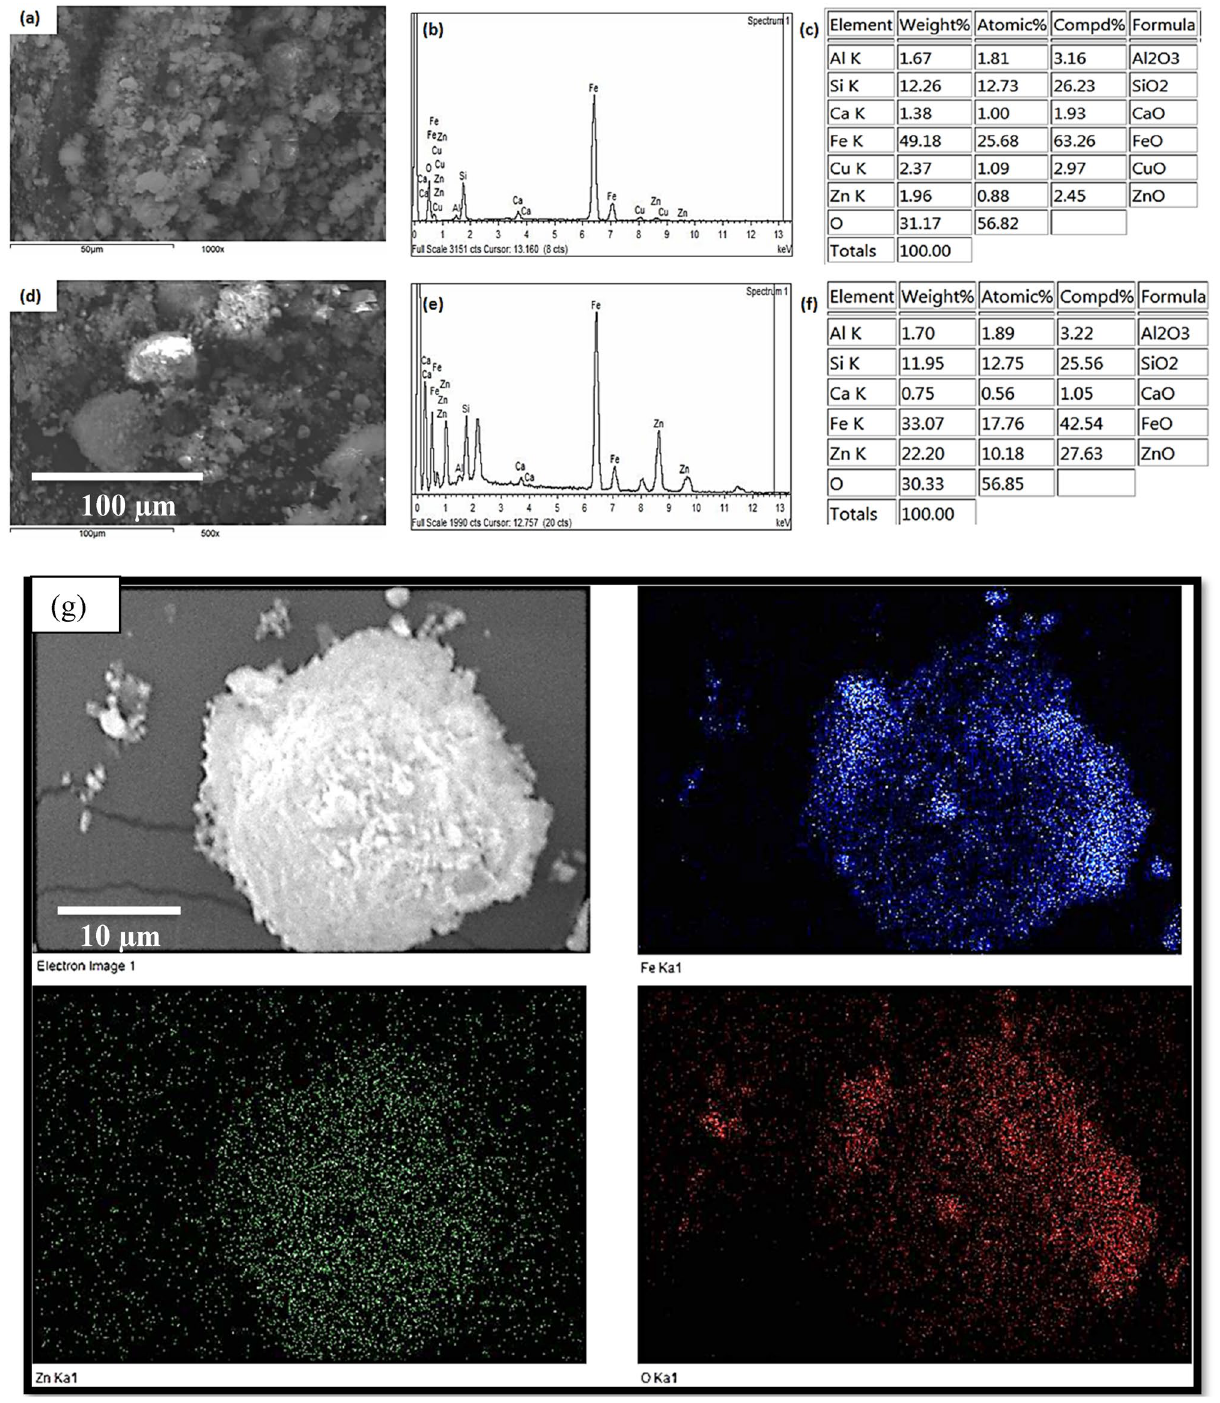
Figure 4. SEM, EDS spectra, and chemical analysis of ( a – c ) BIF and ( d – f ) ZS@BIF and EDS elemental mapping images for 20% ZS@BIF sample ( g